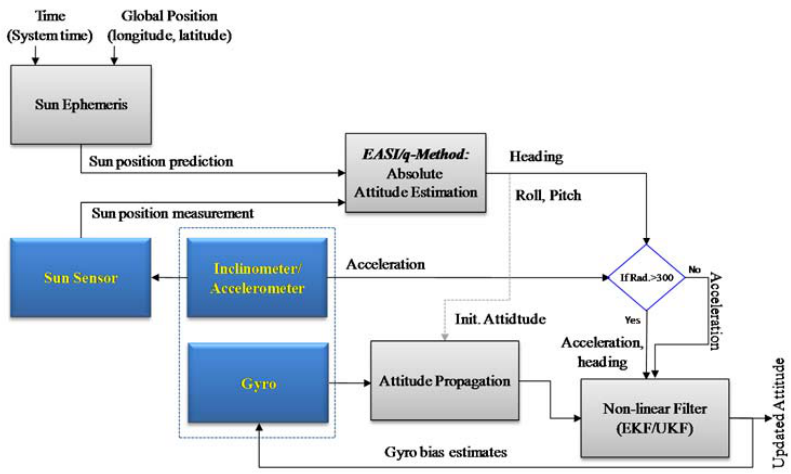
Figure 1. Algorithm block diagram for integrating relative and absolute navigation sensors for attitude estimation.